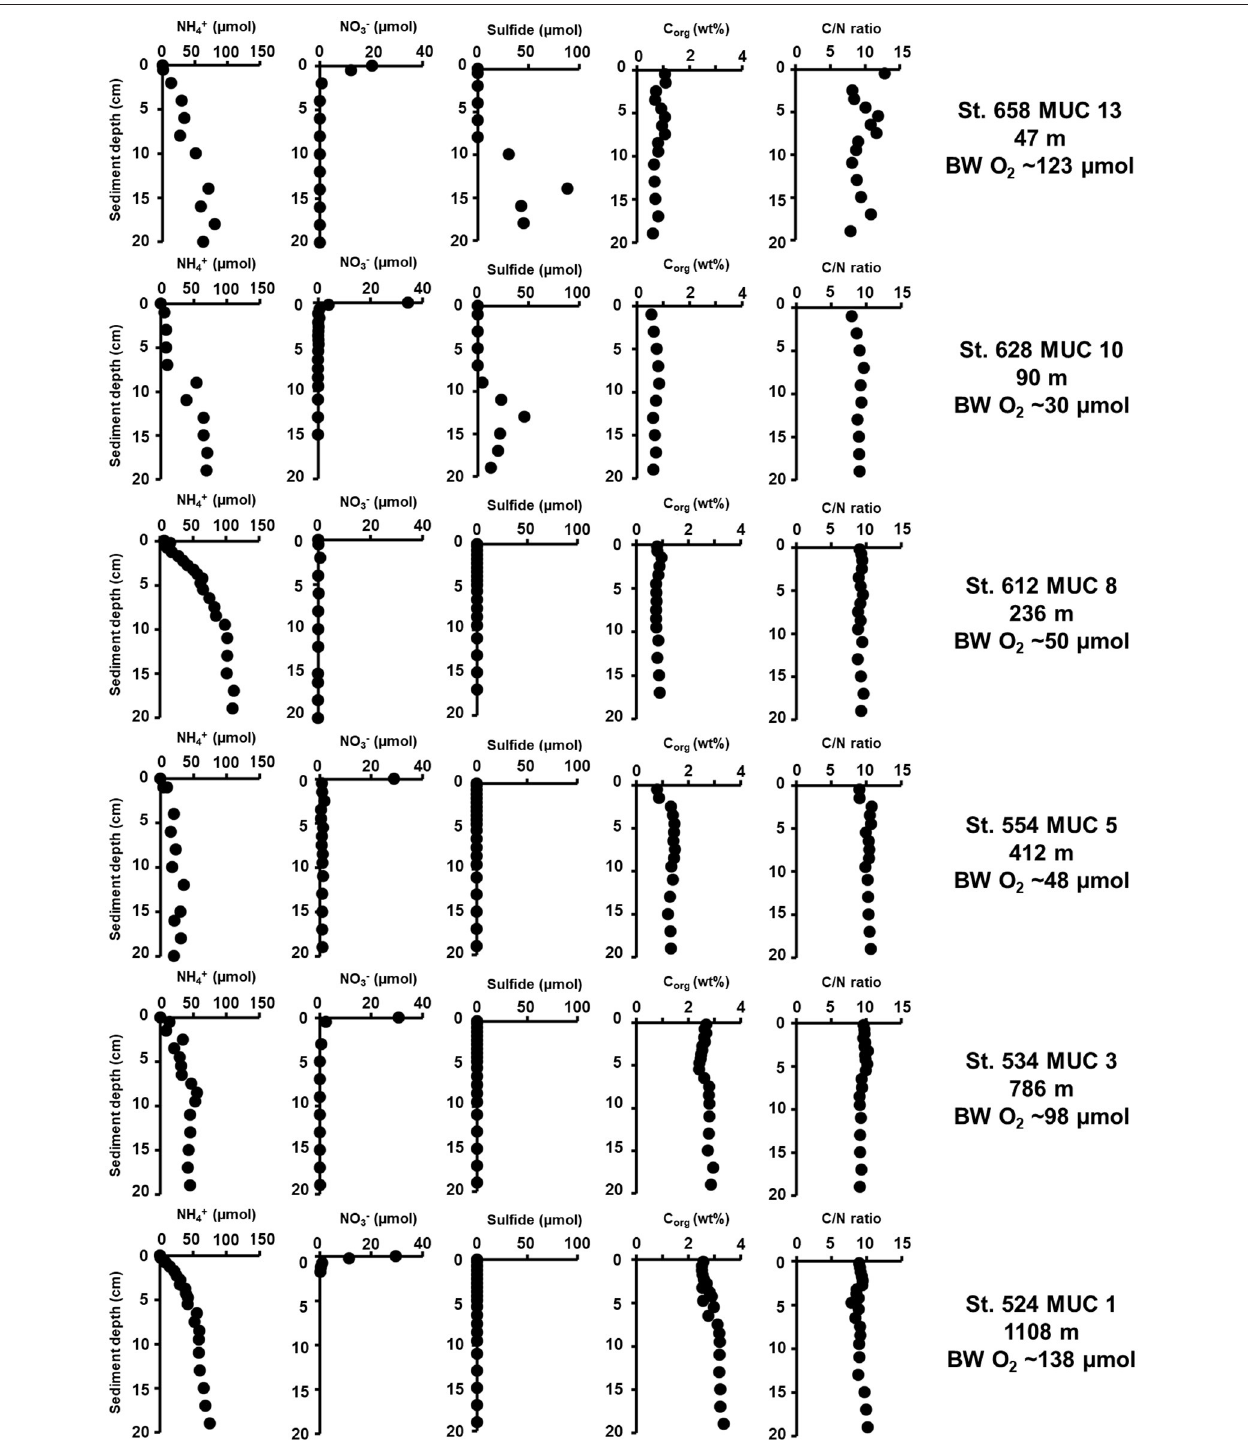
FIGURE 2 | Biogeochemical porewater profiles in sediments cores from sampling stations along the 18 ◦ N transect. Plots show ammonium (NH + 4 , µ M), nitrate (NO − 3 , µ M), sulfide ( µ M), organic carbon content (C org , wt%), and the C/N ratio (molar). Bottom water O 2 concentrations (BW O 2 , µ M) is provided at the right margin.